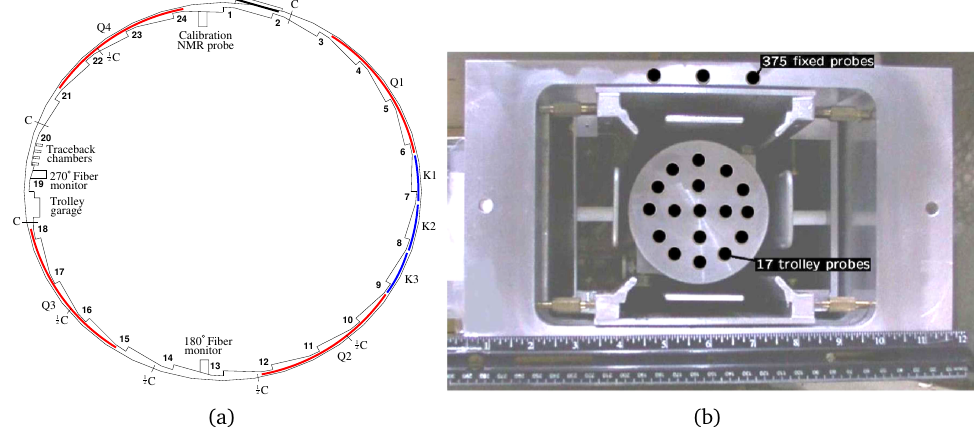
Figure 10: (a) The layout of the muon beam vacuum chamber showing locations of the electric quadrupoles (Q1 - Q4), and the fast muon kickers (K1 - K3). The location of the calorimeters are indicated by numbers at each sawtooth. (From Ref. [ 51 ] ) (b) The inside of a vacuum chamber showing an electrostatic quadrupole, and the NMR field mapping trolley. The location of the NMR probes inside the trolley are indicated by black circles, as are the locations of the fixed NMR probes that are in the outer wall of the muon beam vacuum chamber. (Photo by K.